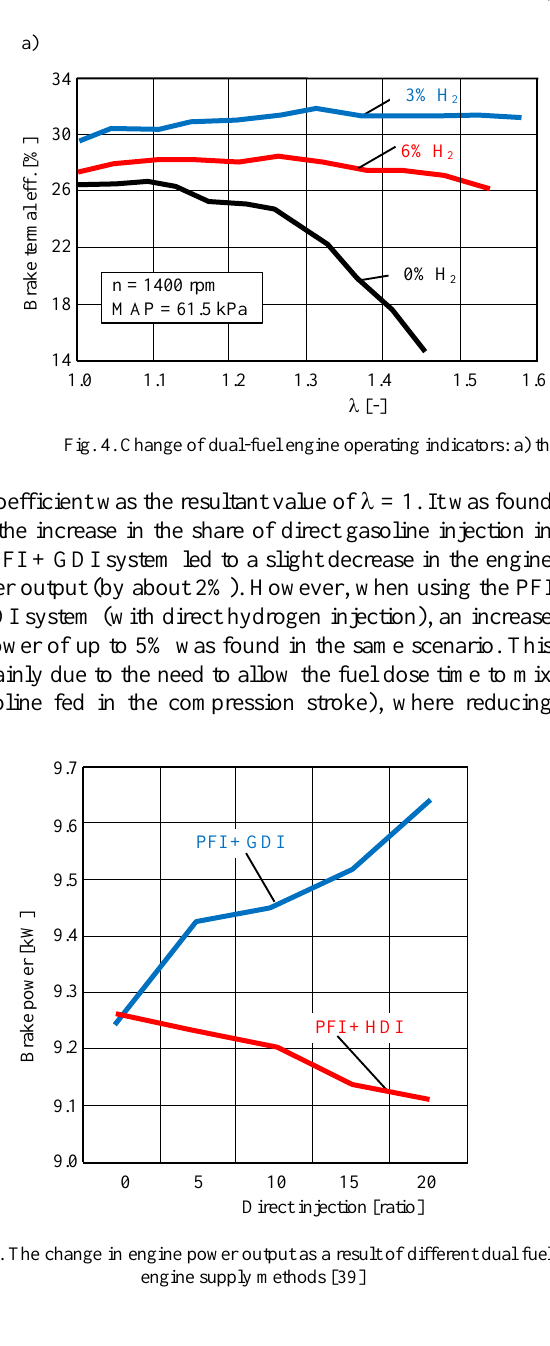
Fig. 3. Dual-fuel engine operating points maps: diesel and gasoline at different values of the excess air coefficient: a)  = 1.72, b)  = 2.72, c)  = 2.77 (reproduced from [26])